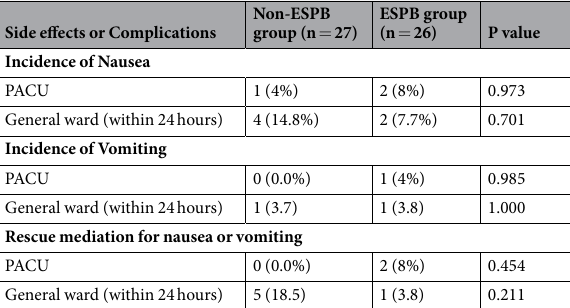
Table 4. Postoperative Complications. Values are expressed as n (%). PACU, post-anaesthetic care